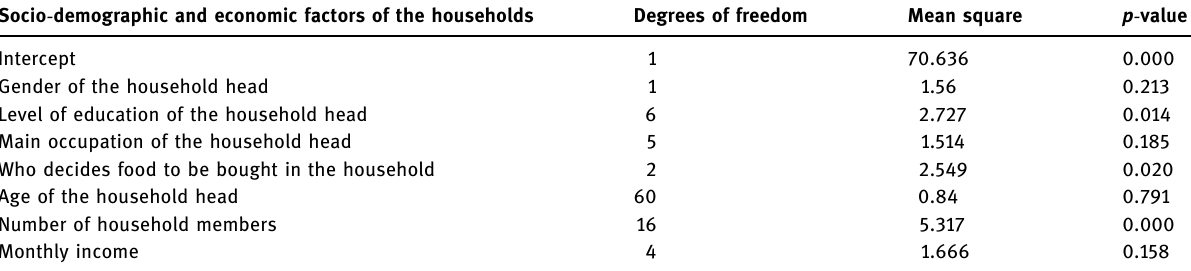
Table 4: General linear model of the frequency of intake of cowpea leaves in a household based on their socio - demographic and economic factors Socio - demographic and economic factors of the